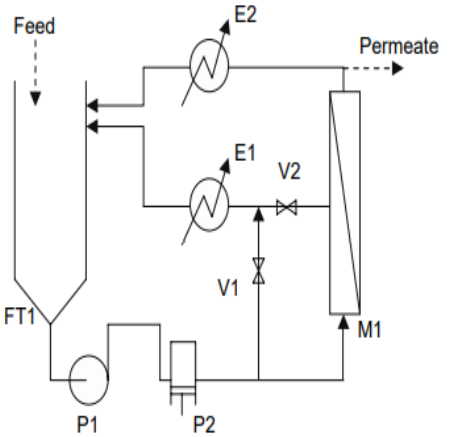
Figure 1. Schematic diagram of the membrane separation system used after the coagulation. Reprinted with permission from Reference [52]. Copyright 2005 Elsevier.